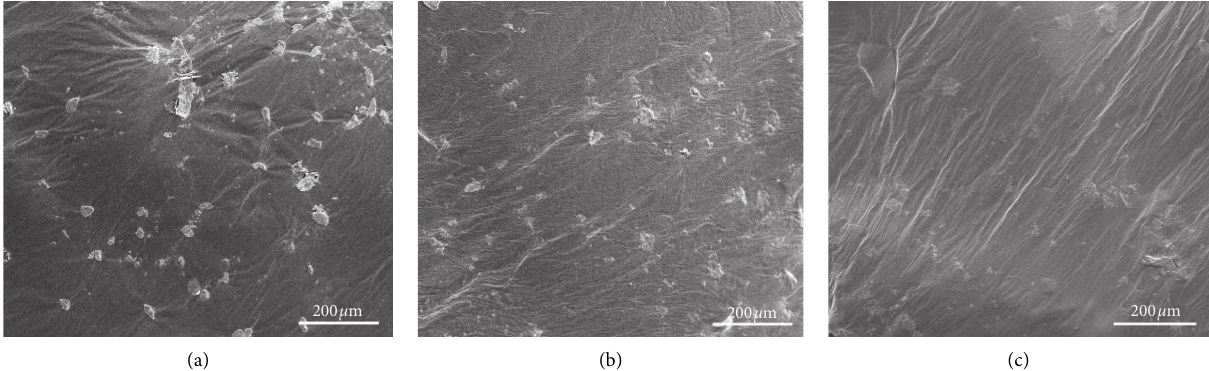
Figure 2: SEM images of AR binders with different CR particle sizes. (a) AR with #40 CR, (b) AR with #60 CR, and (c) AR with #80 CR.